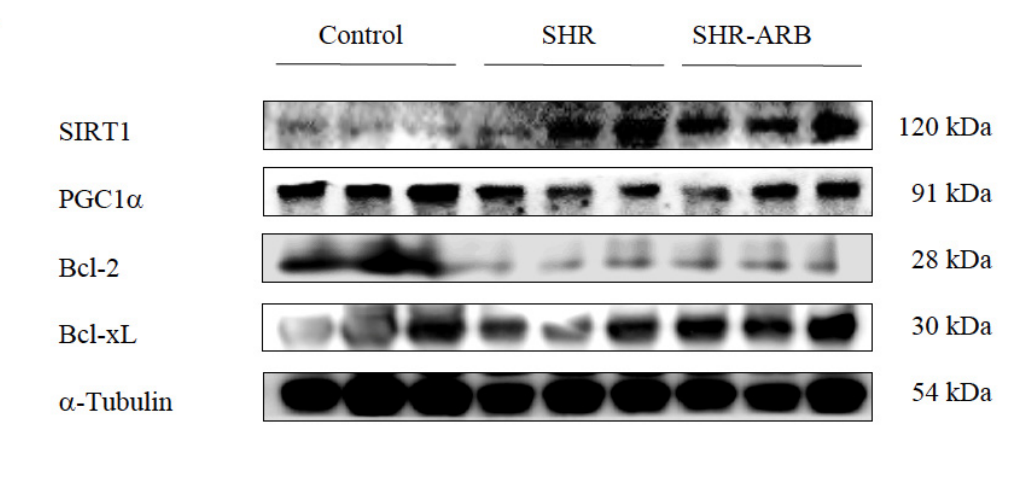
Figure 5. ( A ) The representative protein levels of SIRT1, PGC-1, BcL-2, and BcL-xL extracted from the left ventricles of excised hearts in the normotensive group (WKY), untreated hypertensive group (SHR), and SHR rats with treated irbesartan (SHR-ARB), as measured by Western blot methods. α - Tubulin served as an internal control. ( B ) Bars indicate the relative fold changes of protein levels relative to the Control group in SIRT1, PGC-1, BcL-2, and BcL-xL based on α -Tubulin and show mean ±standard deviation (n = 8;8;8). * p < 0.05, ** p < 0.01: significant differences from the Control group. # p < 0.05, ## p < 0.01 indicates significant differences between the SHR group and the SHR- ARB group.